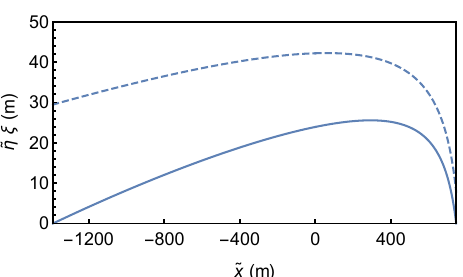
Figure 5. The distributions of non-normalized bed elevation and water surface over one step wave- length, in the upper segment.